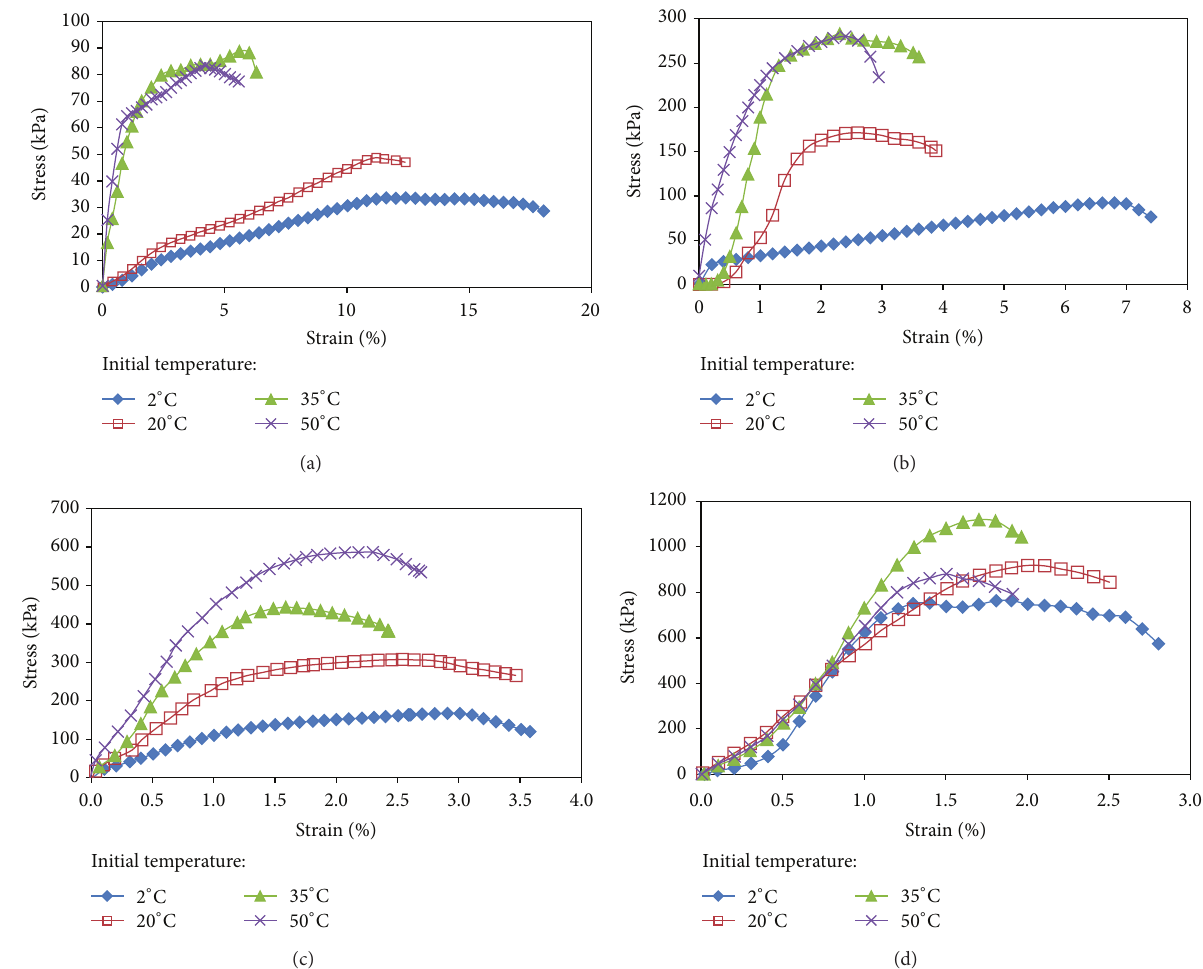
Figure 3: Effect of initial temperature on the stress-strain shape of CPB at different curing times: (a) 0.25, (b) 3, (c) 7, and (d) 28 days.